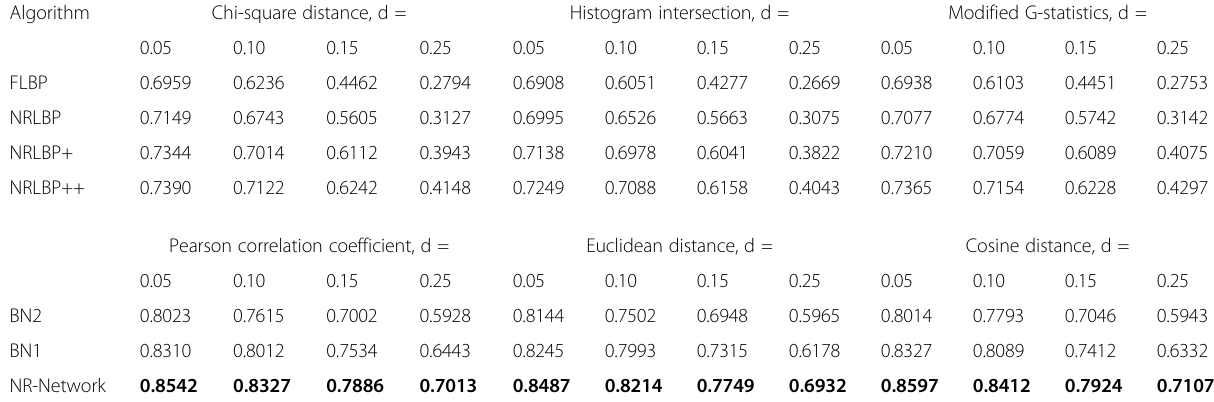
Table 5 The average recognition rates of different methods on the AR database injected with salt & pepper noise Algorithm Chi-square distance, d =